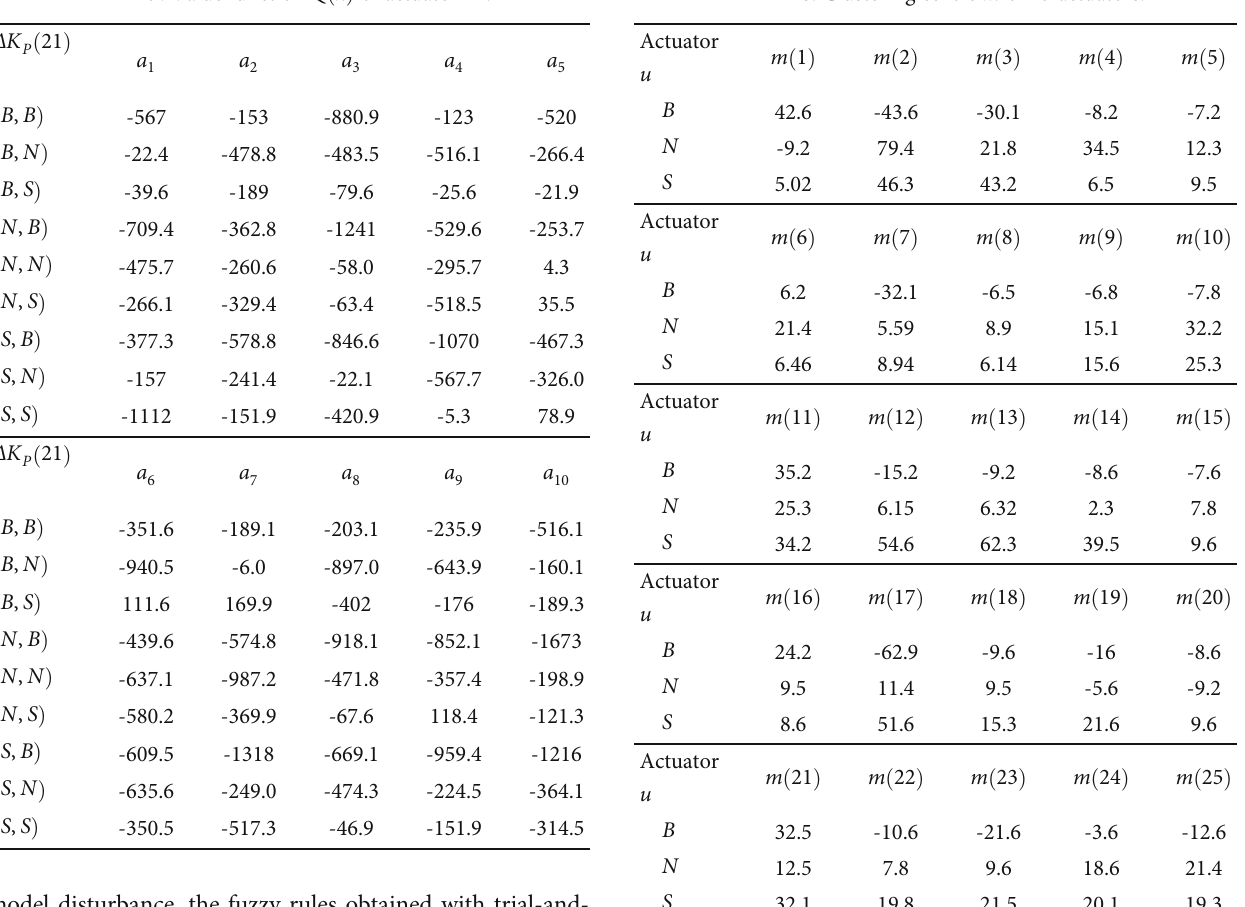
Table 9: Value function Q ð k Þ of actuator 21. Table 10: Clustering centre m of 25